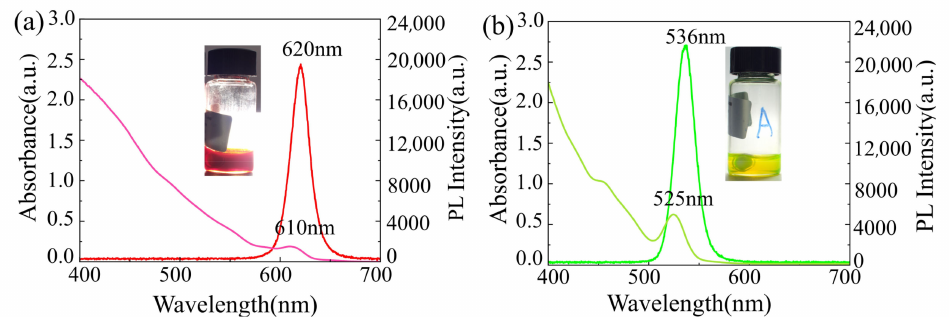
Figure 2. UV-Vis absorption and PL emission spectra of functional quantum dots (inset: pho- tograph of functional QDs dispersed in SR399 monomer observed under visible light): ( a ) red CdSe/CdZnS/ZnS QDs; ( b ) green CdSe/ZnS